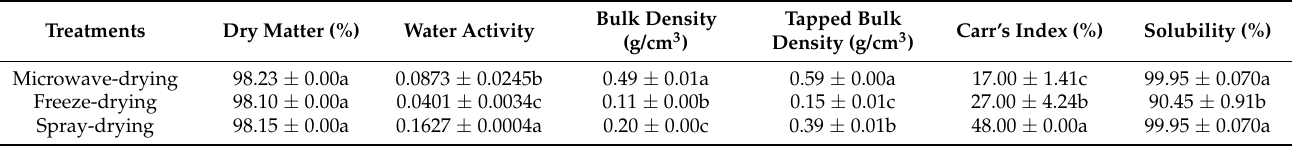
Table 7. Physical properties of microencapsulated